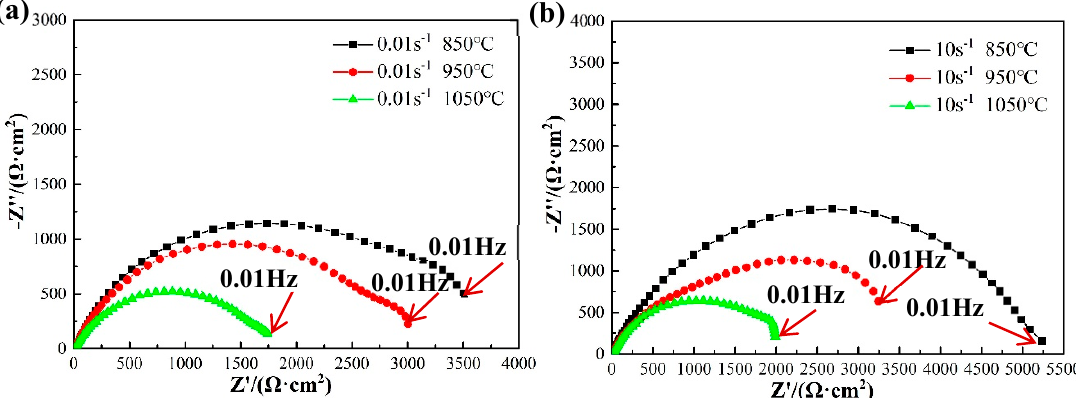
Figure 6. Nyquist plots of the 35CrMoV steel in 3.5 wt% NaCl solution: ( a ) 0.01 s − 1 , 850–1050 °C; ( b ) 10 s − 1 , 850–1050 °C.